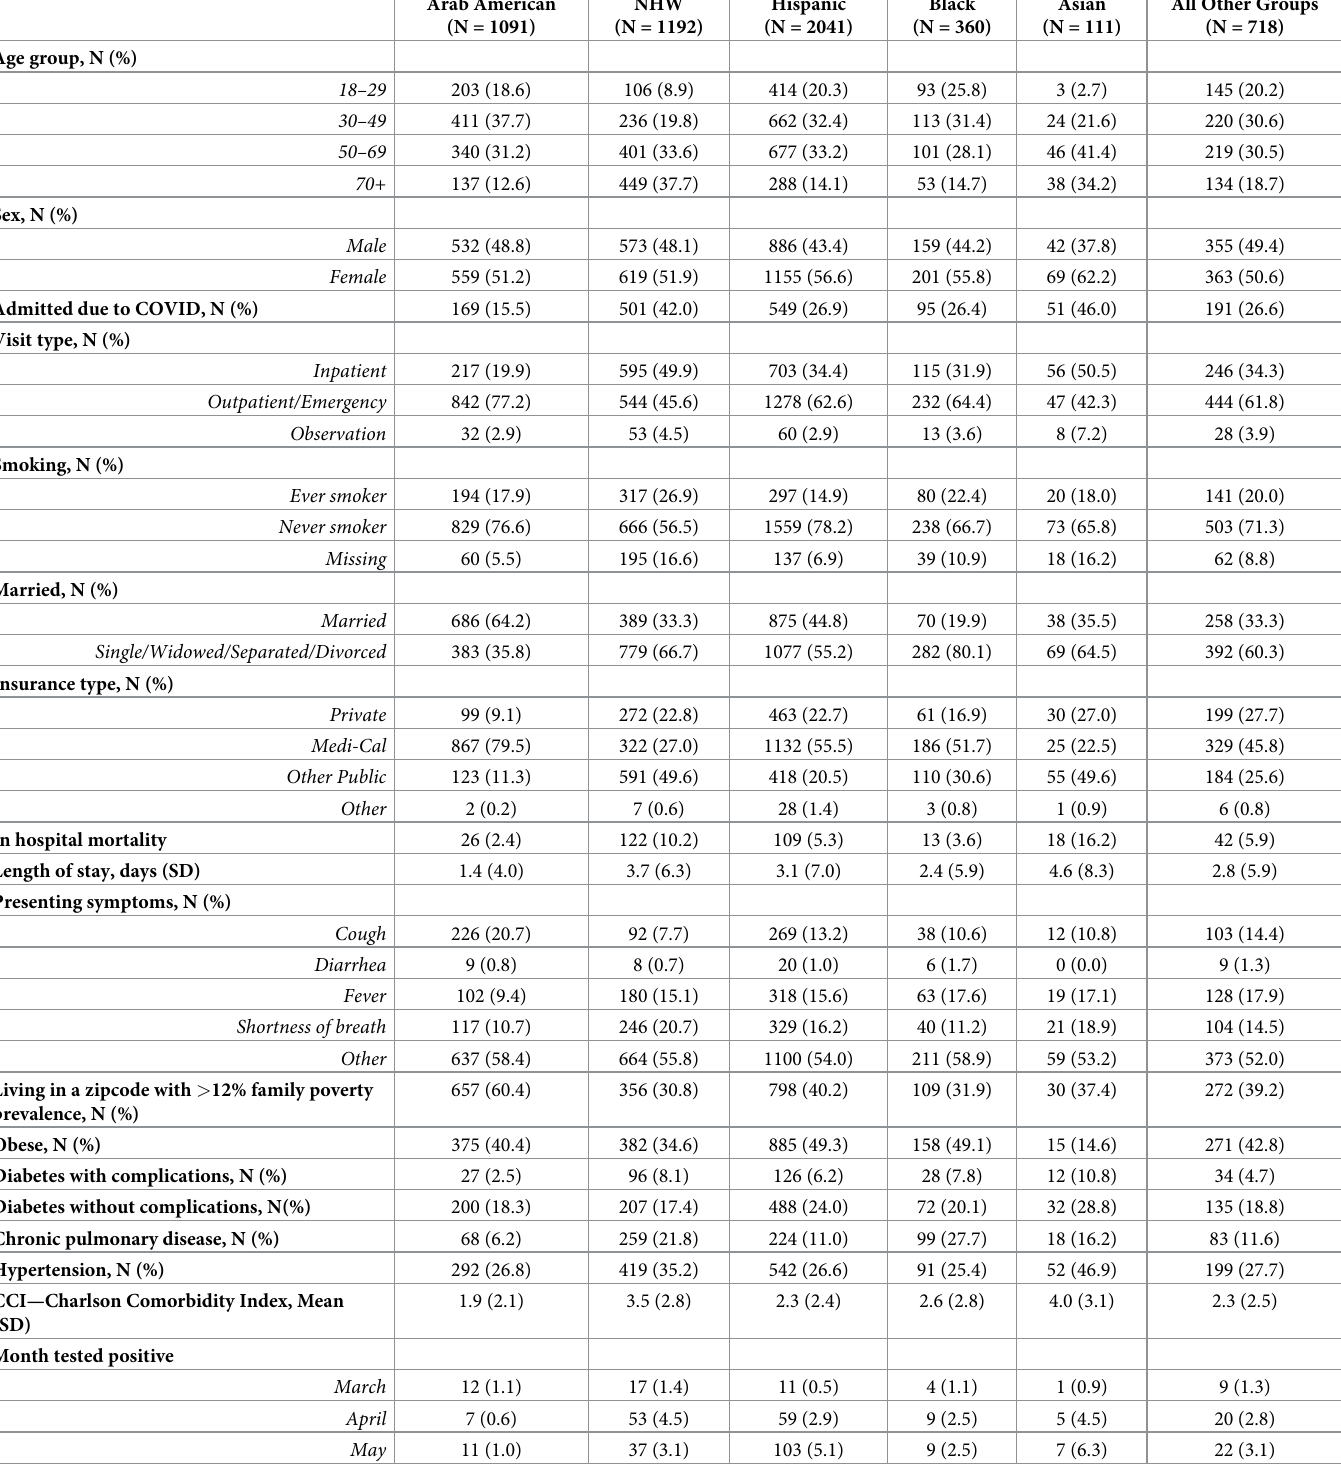
Table 2. Comparison of sociodemographics and outcomes across racial and ethnic groups among patients who tested positive for COVID-19 in the Sharp Gross- mont electronic medical record between March 1, 2020 and January 31,